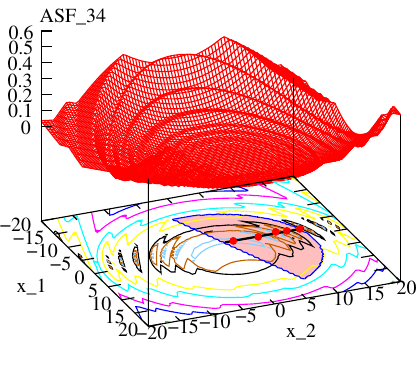
Figure 3. In-fill solutions for different frameworks for SRN problem. True functions are plotted here, however, different metamodeling frameworks use different approximations to find in-fill solutions on the true PO